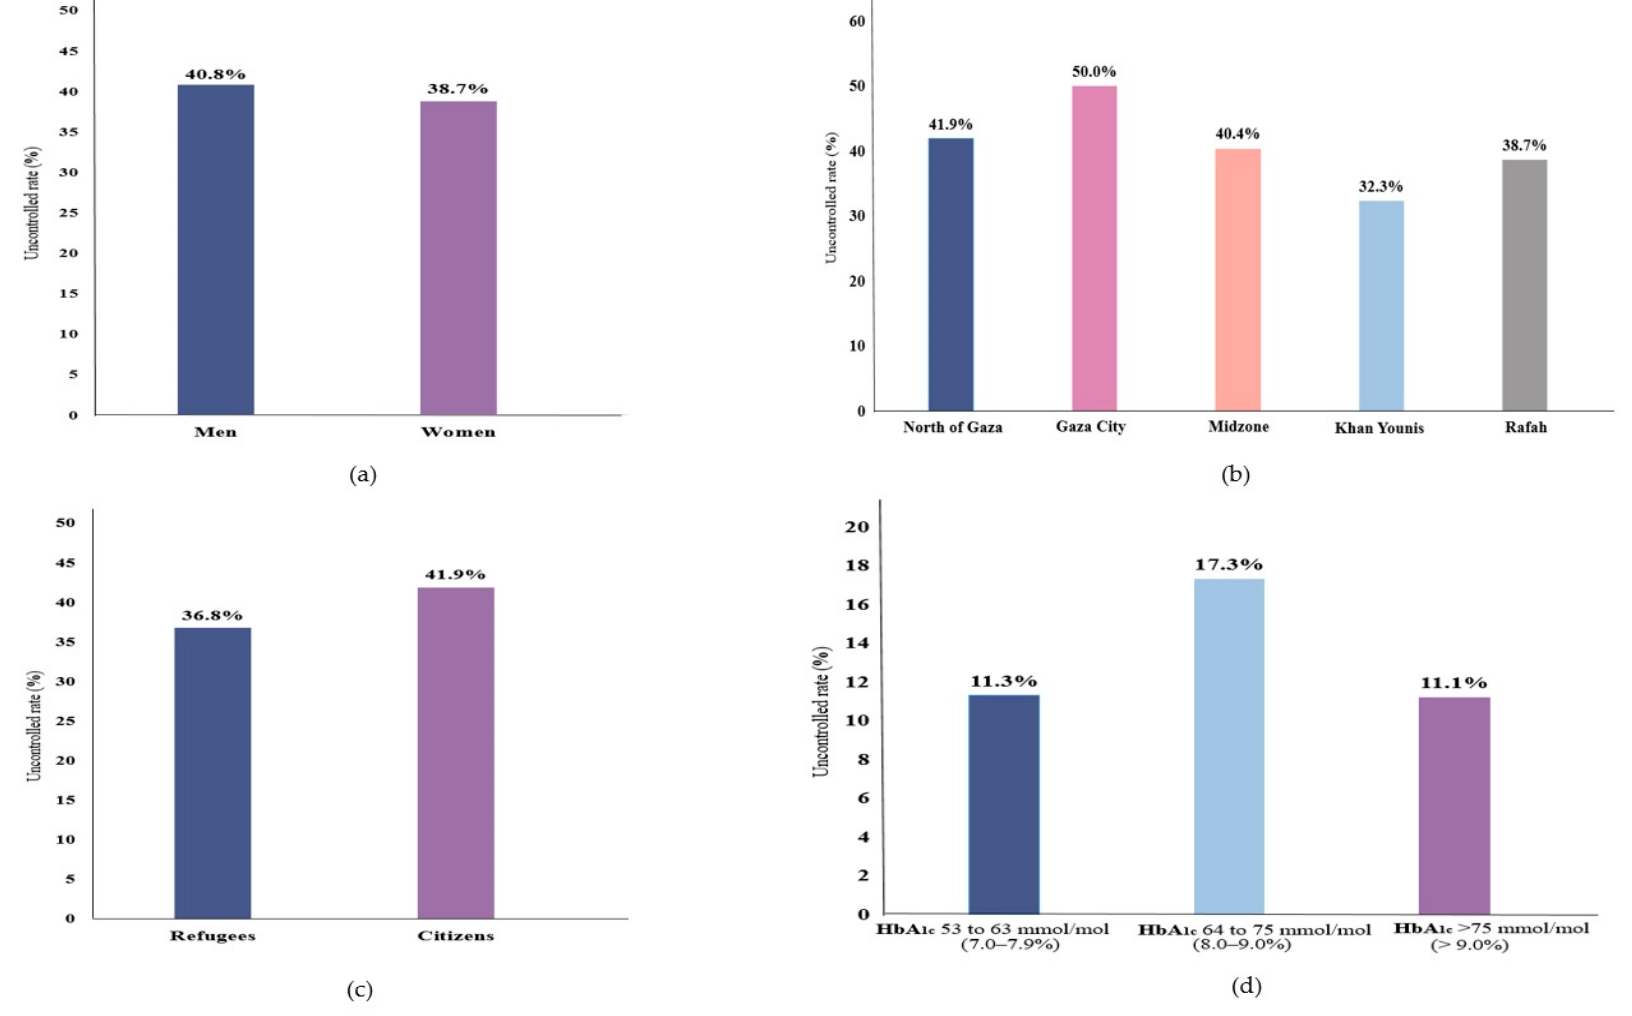
Figure 2. Uncontrolled glycaemic rate of T2D among diagnosed T2D by ( a ) sex, ( b ) region, ( c ) population, and ( d ) HbA 1c values category.